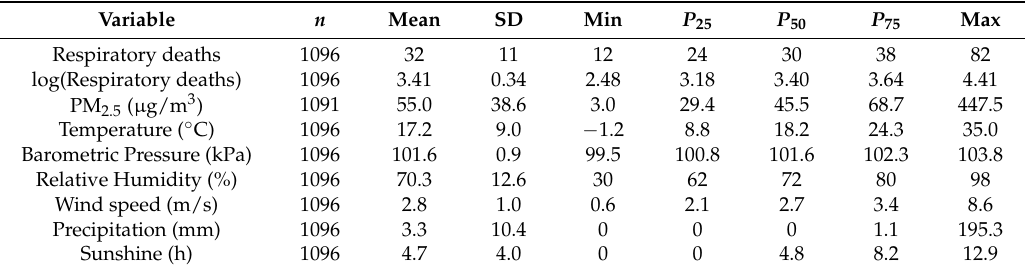
Table 1. Descriptive statistics of daily respiratory deaths, ambient PM 2.5 concentrations, and major meteorological variables.